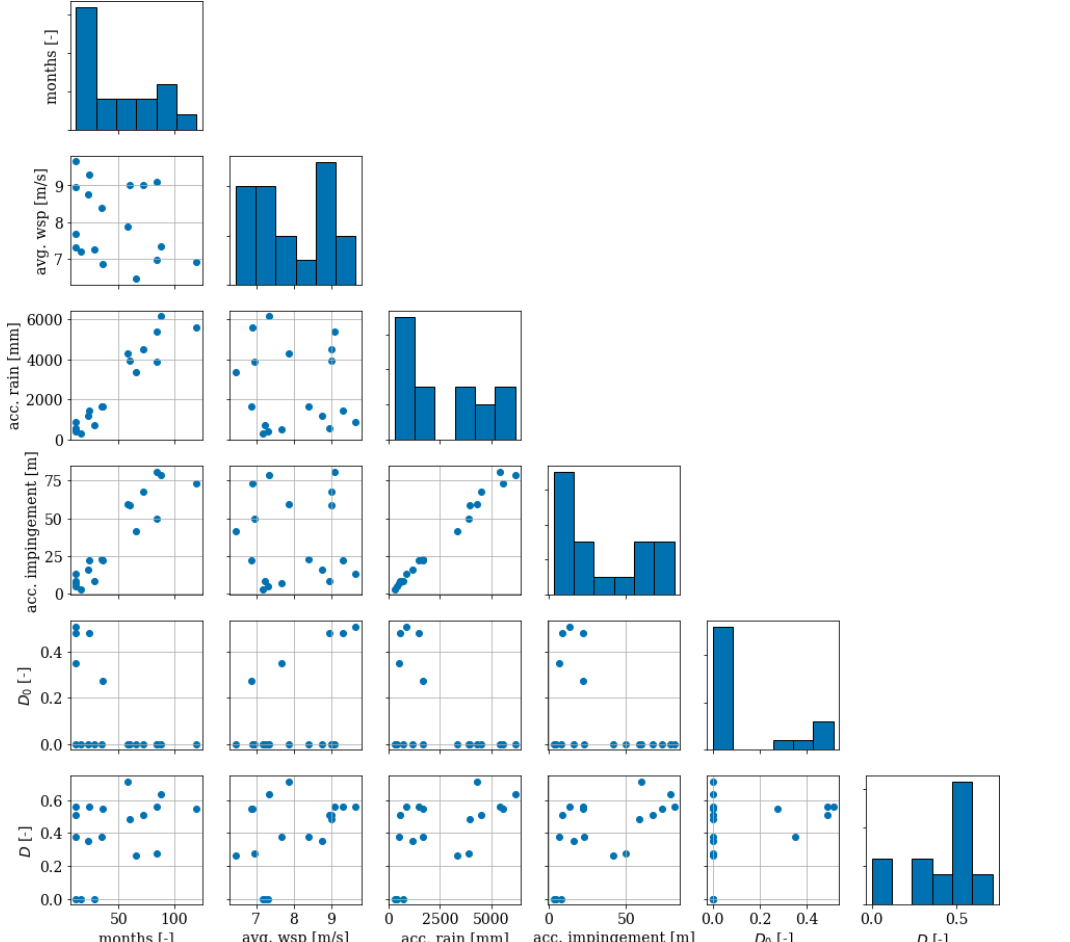
Figure 9. Correlation matrix showing the pairwise relationships for key parameters in the dataset as well as histograms in the diagonal. D refers to the encoded damage at the end of a sequence (used as target feature); D 0 is the encoded initial damage observed at the beginning of a sequence (used as input feature); and avg. wind speed, acc. precipitation, and acc. impingement (used as input feature) refer to the average wind speed, accumulated precipitation, and accumulated impingement, respectively, for the available